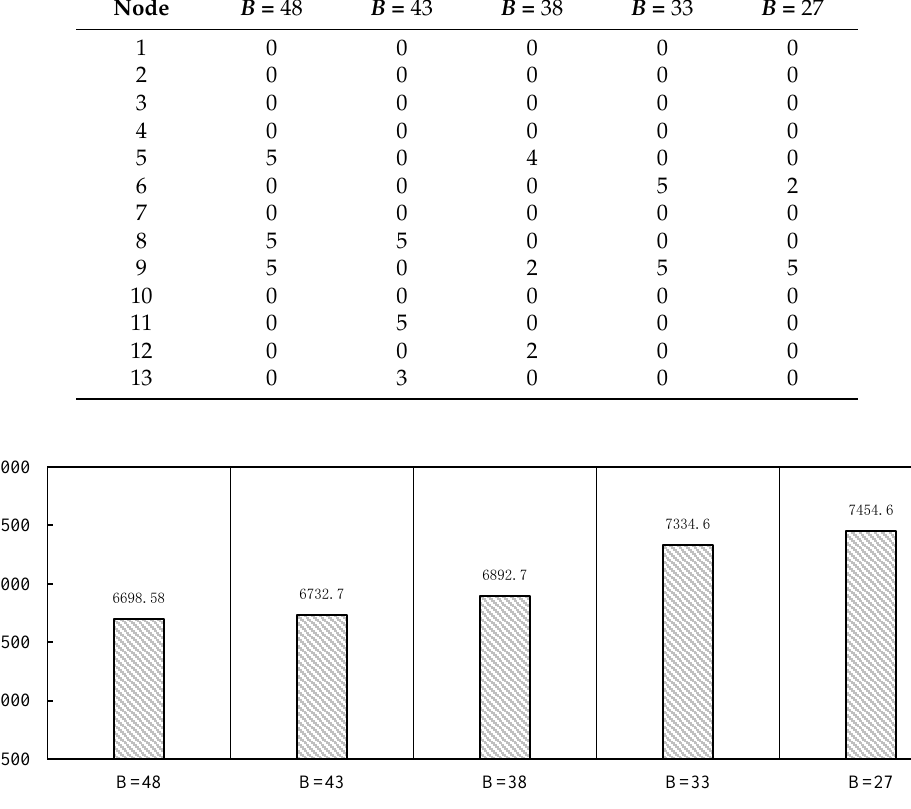
Figure 11. Comparison of the total trip time for various total cost budgets. Table 14. Number of chargers in each node for various total cost budgets.